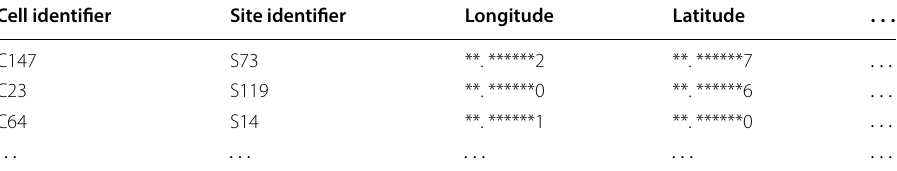
Table 3 Sample of cells and sites database